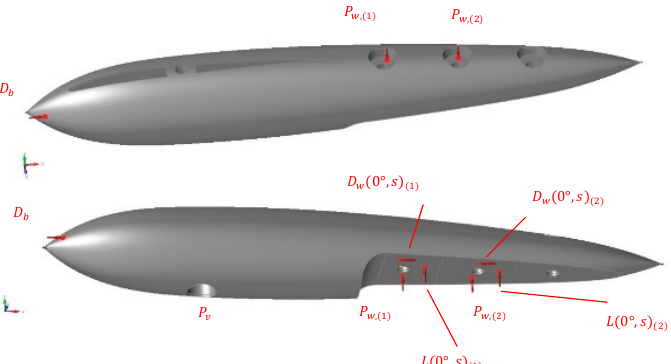
Figure A2. Working (0 ◦ , s ) load case, constraints are hidden for representation purpose. The overall longitudinal length of the component is 290 mm.